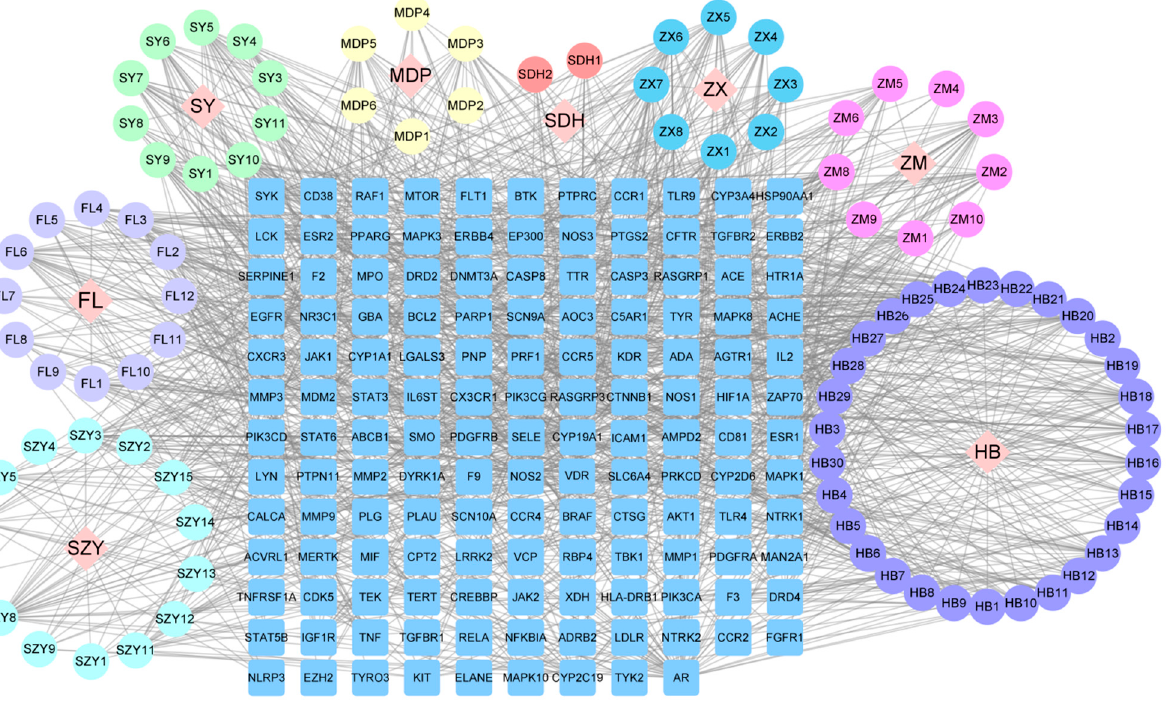
Figure 3. Chinese herbal medicine—active ingredient—intersection target. (Square: common target of active ingredient and disease; Round: drug active ingredient; Diamond: drug of ZBDHP). Table 1. Active ingredients of Zhibai Dihuang Pill. (top 10).